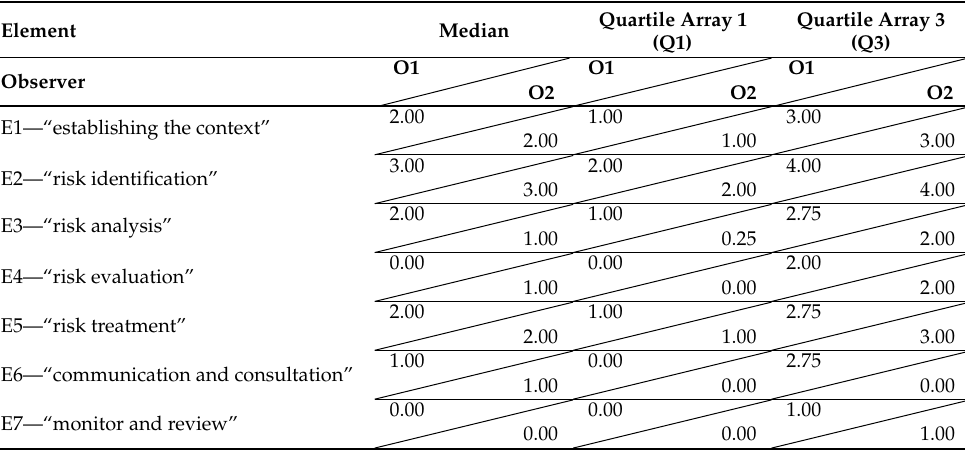
Table 2. Medians and interquartiles competence ratings given by two observers for the seven elements of the risk management process (all